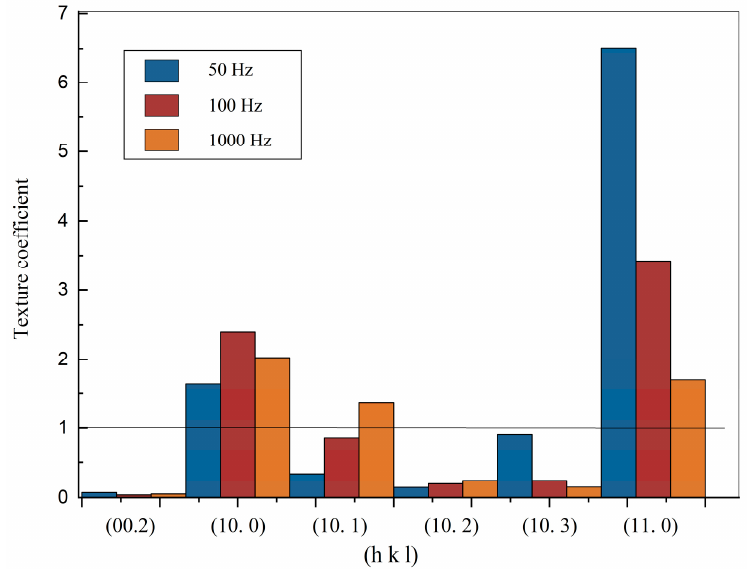
Figure 3. XRD patterns of electrodeposited zinc under 50 Hz, 100 Hz, and 1000 Hz pulse frequency.